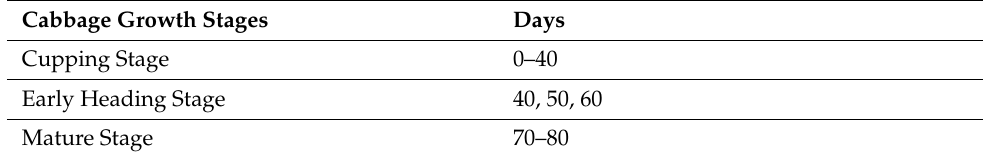
Figure 20. Correlation analysis between cabbage growth stages and NDVI values. Table 6. Cabbage growth stages.